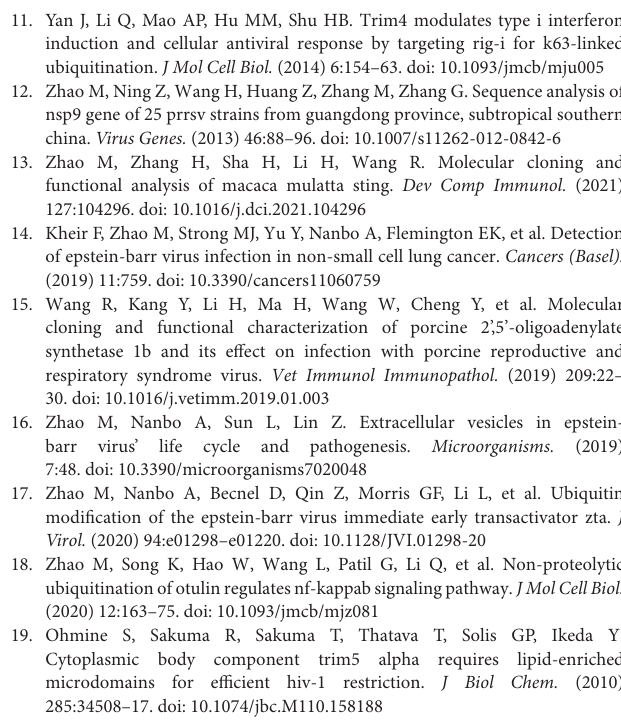
Supplementary Figure 1 | Phylogenetic analysis of TRIM4 from different species. TRIM4 sequences of Homo sapiens (NM_033017), Macaca mulatta (MZ706948), Bos taurus (XM_005225267), Sus scrofa (XM_003124333), Capra hircus (XM_004021042), Equus przewalskii (XM_008536543.1) and Pan troglodytes (XM_009453742) were analyzed using Mega 5.0 software, and an evolutionary tree was obtained. Supplementary Figure 2 | Effects of PRRSV infection on TRIM4 expression and effects of TRIM4 on PRRSV replication. (A) Evaluation of different PRRSV MOI on TRIM4 expression. MARC145 cells were infected with different PRRSV MOIs (0.01, 0.1, and 1), and after 48h, the changes in TRIM4 mRNA expression were measured by qPCR and western blotting. (B) Evaluation of different time points with the same PRRSV MOI on TRIM4 expression. MARC145 cells were infected with 1 MOI PRRSV, and changes in TRIM4 expression were examined by qPCR and western blotting at different time points (0, 12, 24, 36, 48, 60, and 72h). (C) TRIM4 overexpression inhibits PRRSV replication. FLAG-TRIM4 (500 ng) was transfected into Marc-145 cells; cells were inoculated with 1 MOI PRRSV after 24h, and the supernatant of cells was collected after 48h post-infection, the virud titer was measured by TCID 50 . Supplementary Table 1 | Primers used in this